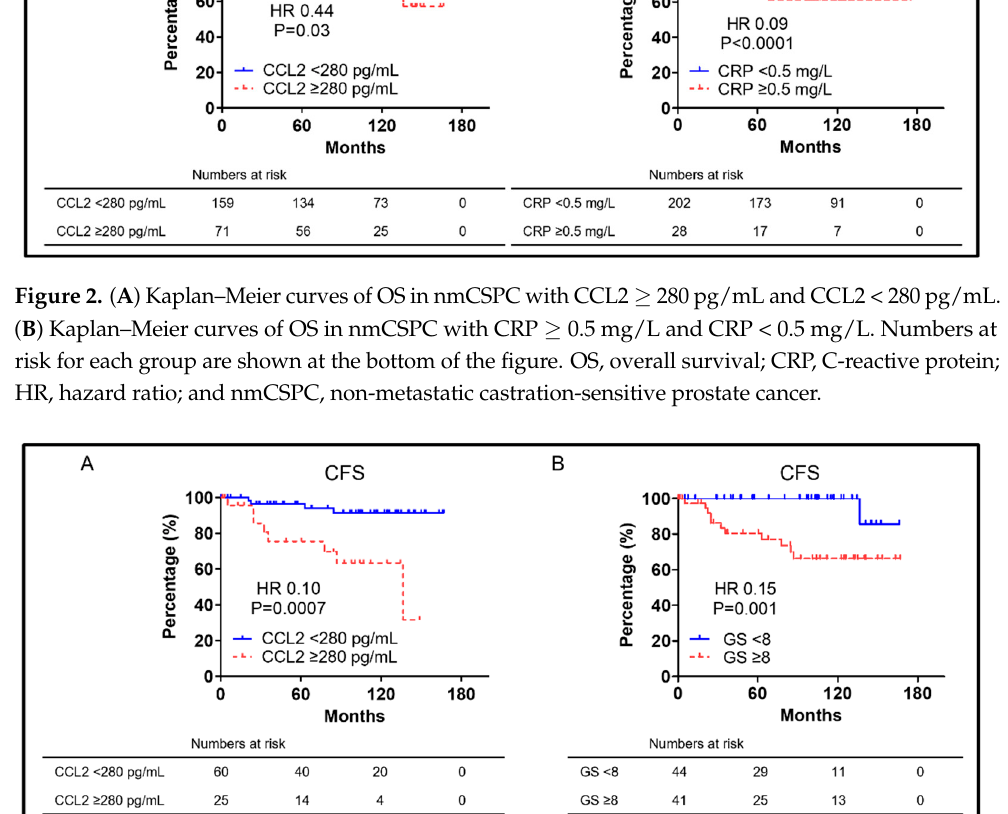
Figure 2. ( A ) Kaplan–Meier curves of OS in nmCSPC with CCL2 ≥ 280 pg/mL and CCL2 < 280 pg/mL. ( B ) Kaplan–Meier curves of OS in nmCSPC with CRP ≥ 0.5 mg/L and CRP < 0.5 mg/L. Num- bers at risk for each group are shown at the bottom of the figure. OS, overall survival; CRP, C- reactive protein ; HR, hazard ratio; and nmCSPC, non-metastatic castration-sensitive prostate can- cer.